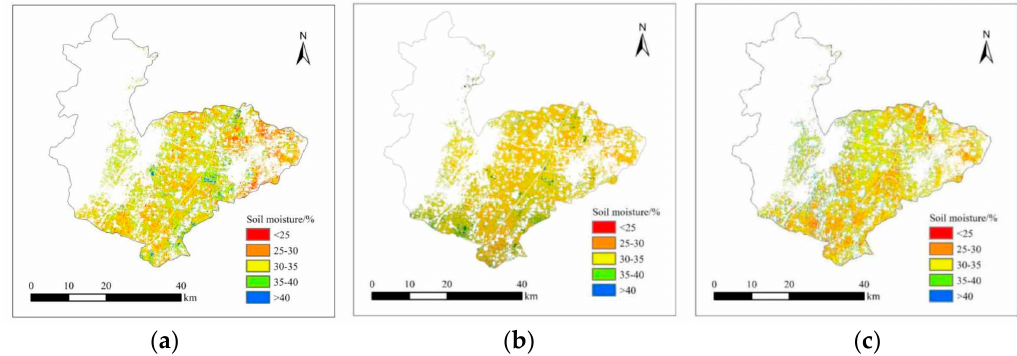
Figure 7. SSM maps of wheat ‐ covered fields in study area. ( a ) 3 April 2019. ( b ) 3 May 2019. ( c ) 23 May 2019.